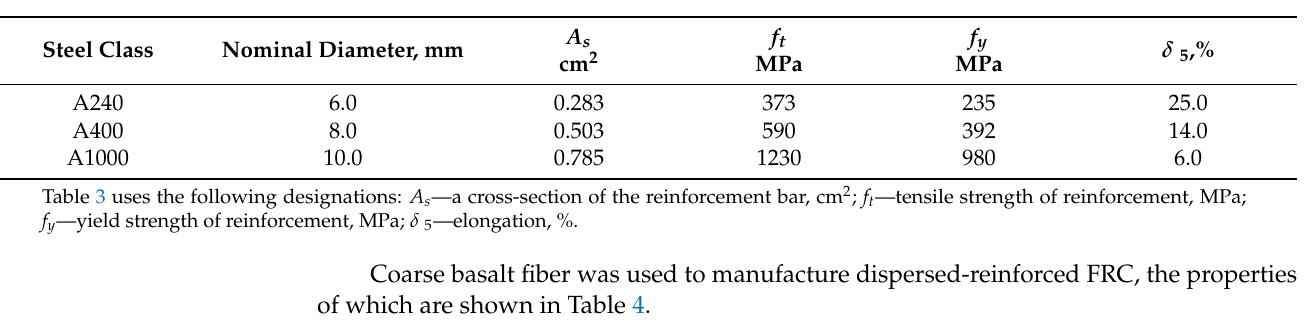
Table 3. Strength and strain characteristics of steel bar reinforcement used for short columns.